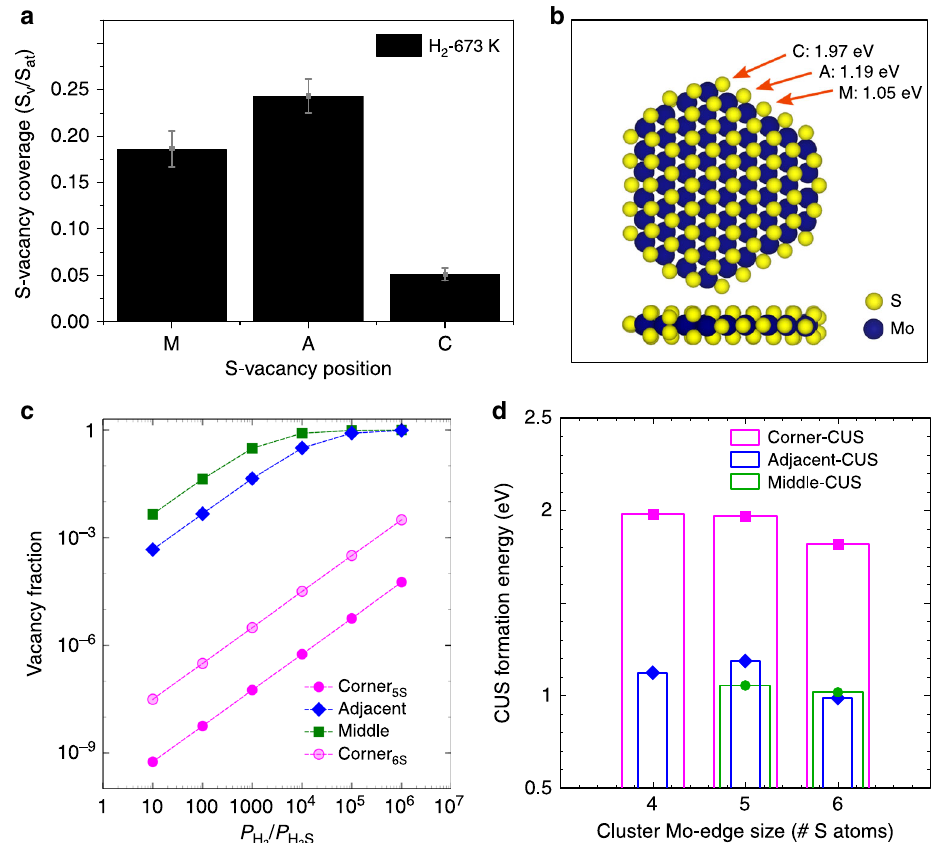
Fig. 2 Site-dependent vacancy formation on MoS 2 -edges. a Bar plot showing the observed frequency of fi nding a V S on corner (C), adjacent (A) and middle (M) sites as determined from atom-resolved STM images. b . Top and side-view ball model of the r -MoS 2 nanoparticle (5S monomer long Mo-edge) used in the DFT model. The calculated V S formation energies ( E S ) for the M, A, and C edge sites, respectively, are given in eV (positive values are endothermic, see supplementary information). c Theoretically predicted V S fraction (log scale) at each site as a function of the ratio of H 2 and H 2 S partial pressures at 673 K. d Size-dependent variation of the V S formation energy (CUS formation) for particle models exposing 4 to 6S monomers along the Mo- edge (corresponding structures are shown in Supplementary Fig. 4). Corner position (square), Adjacent position (diamond), Middle position